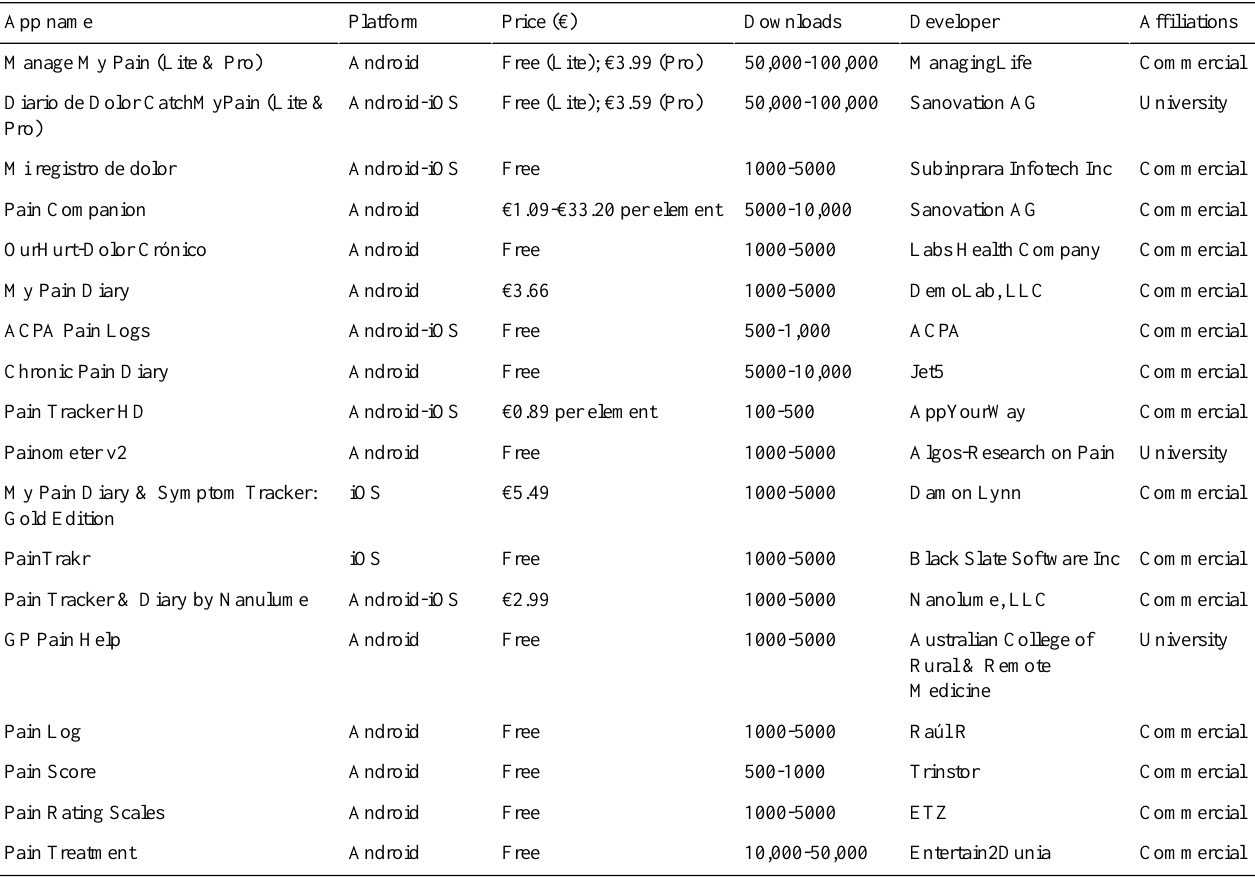
Table 2. Description of the pain-related apps included in the